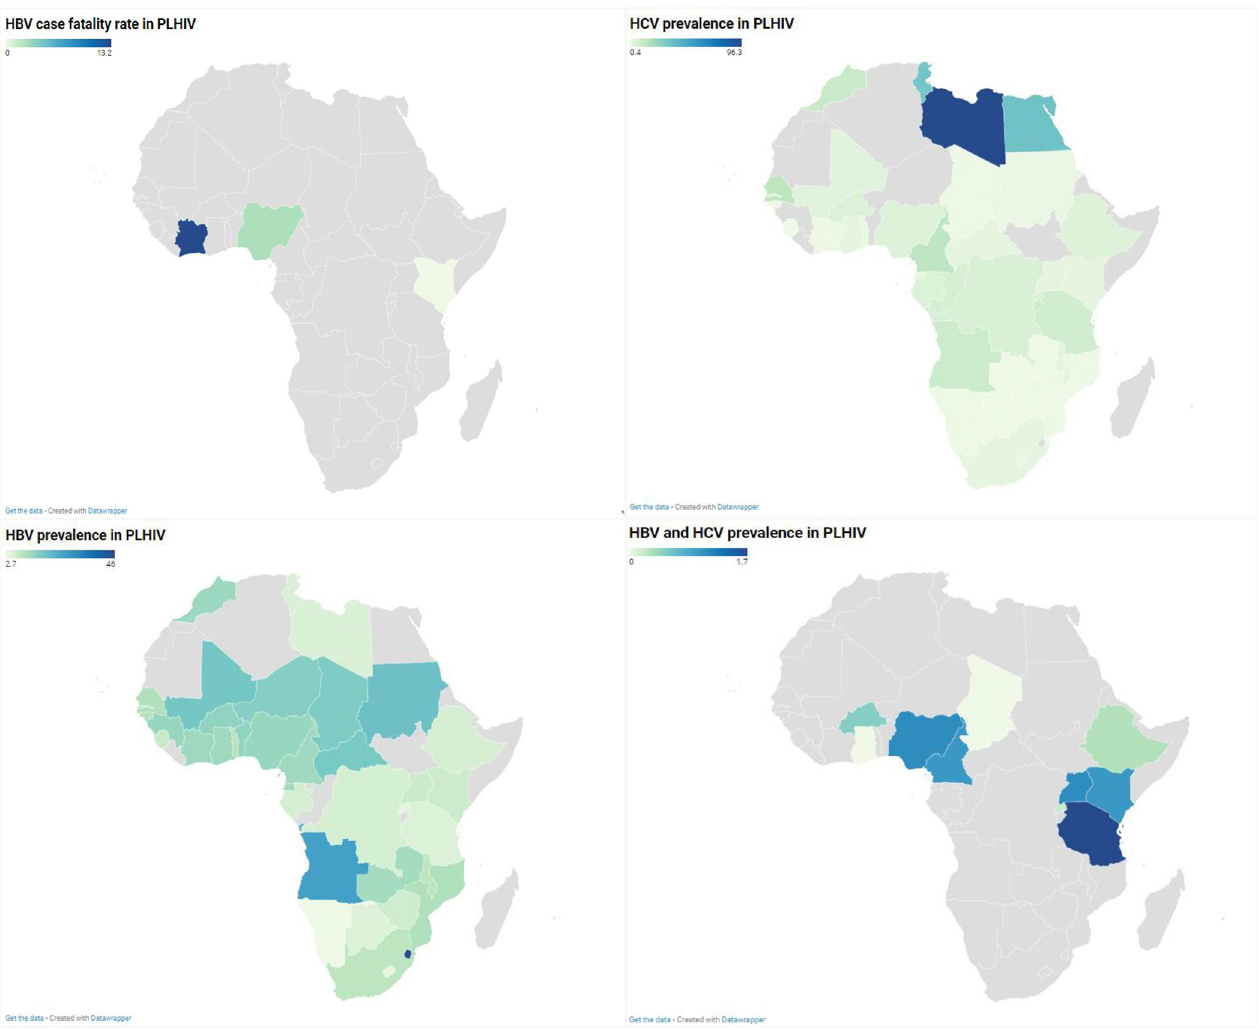
Fig 2. HBV case fatality rate and prevalence estimates of HBV and/or HCV infections in PLHIV in Africa.